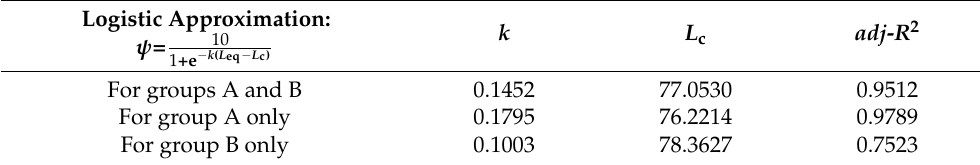
Table 2. Fitting parameters and fitting evaluation for the relationship between annoyance score and